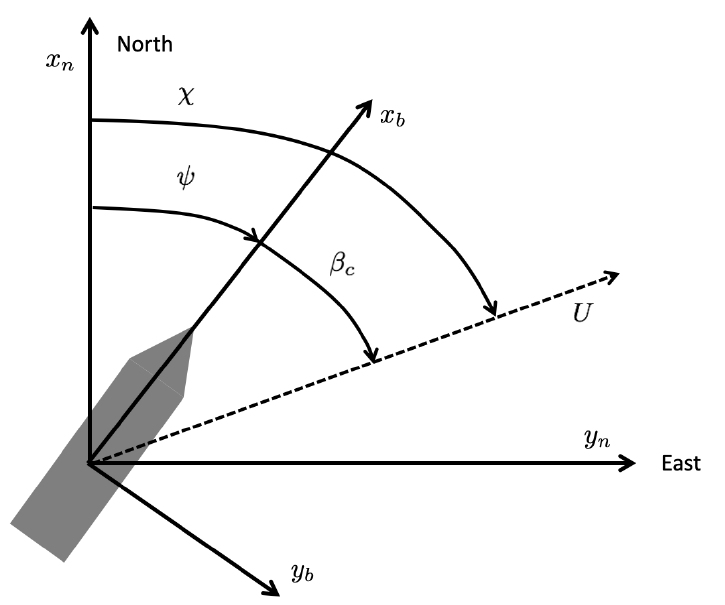
Figure 3. Heading, course, and crab